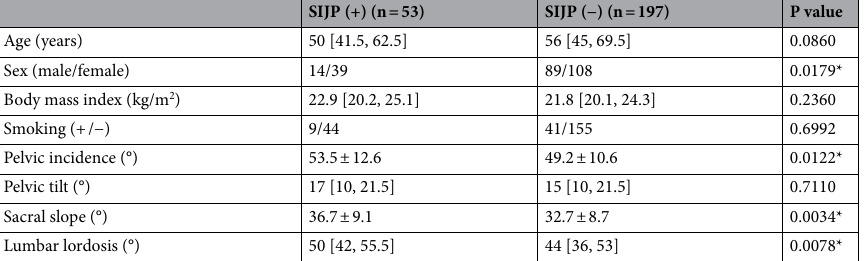
Table 1. Demographic characteristics and spinopelvic parameters by univariate analyses. Data are presented as means ± standard deviation for parametric items and medians and first/third quantiles for non-parametric items, or as numbers of participants (%). SIJP sacroiliac joint-related pain. *P < 0.05. The P values were calculated by Student’s t-test and the Wilcoxon rank sum test for parametric and non-parametric items, respectively.